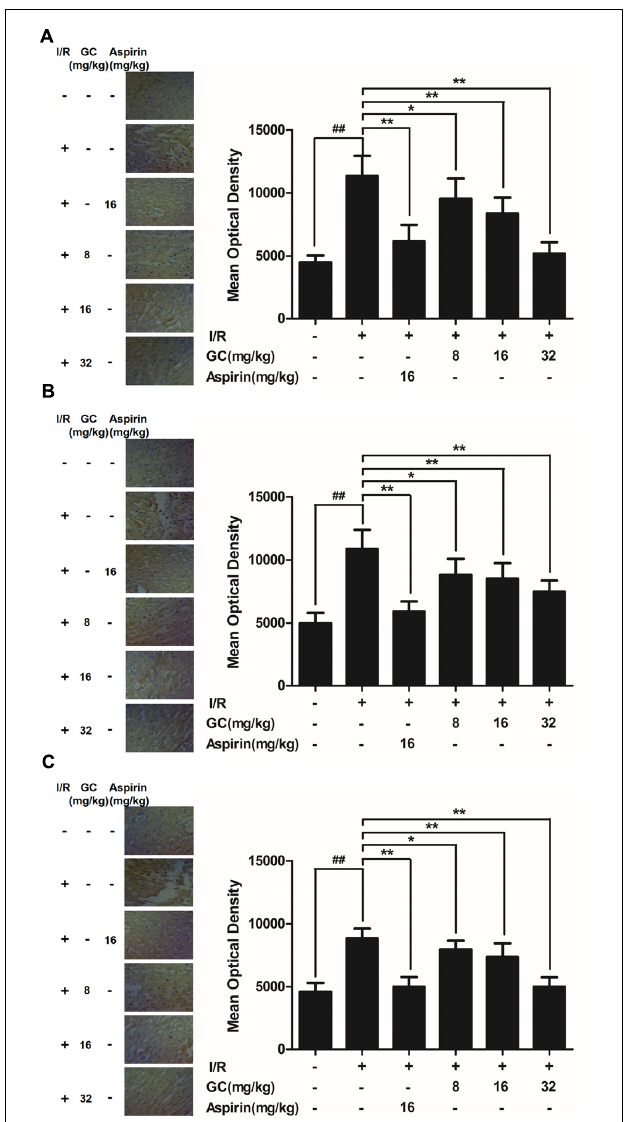
FIGURE 5 | Effect of GC on ICAM-1, VCAM-1 and iNOS expressions in myocardial tissue after I/R procedure. The tissue was observed using a microscope at a magnification × 400. (A) GC decreased the expression of ICAM-1. (B) GC decreased the expression of VCAM-1. (C) GC decreased the expression of iNOS. There was a little expression of ICAM-1, VCAM-1 and iNOS in myocardial tissue of the control group. The expressions of ICAM-1, VCAM-1 and iNOS in I/R group were markedly increased. Administration of GC exhibited reduced expressions of ICAM-1, VCAM-1 and iNOS compared with the I/R group in a dose-dependent manner. Administration of Aspirin also significantly decreased the expressions of ICAM-1, VCAM-1 and iNOS compared with I/R group. The location of the histological images was taken in the infarcted area. Data were expressed as mean ± SD ( n = 8). ## P < 0.01 vs. control group; ∗ P < 0.05, ∗∗ P < 0.01 vs. I/R group.